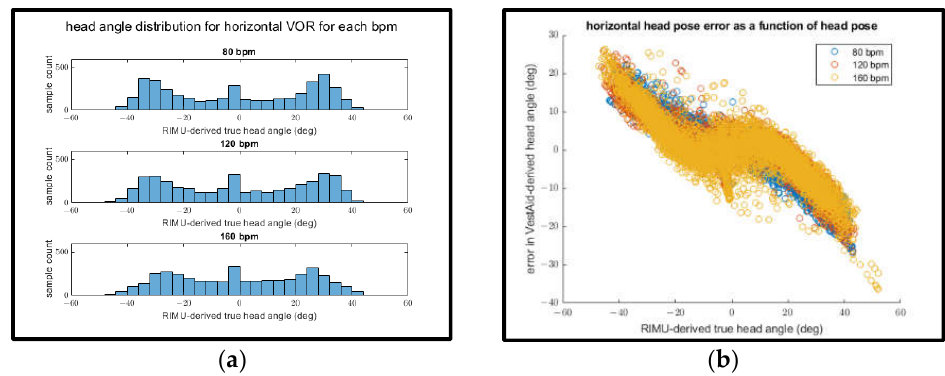
Figure 16. ( a ) IMU-derived head angle distribution for all trials of horizontal VORx1 exercises at different bpms; ( b ) error in the horizontal head pose angle vs. IMU-derived head angle.